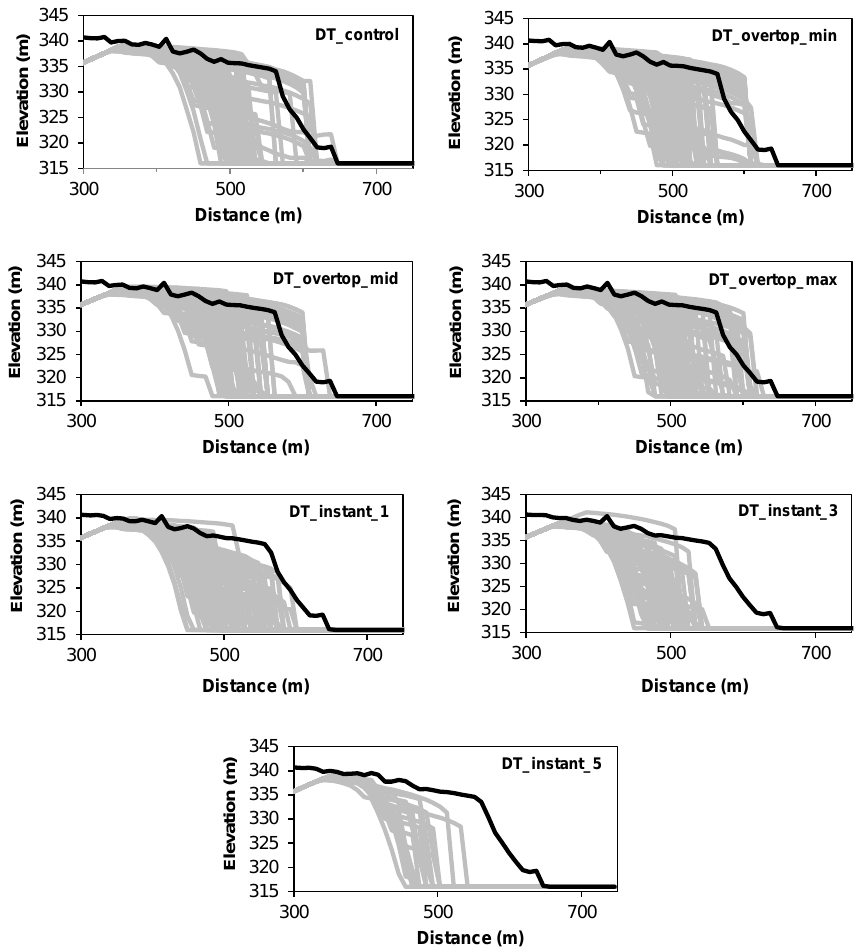
Figure 8. Final centreline breach elevation profiles for the Dig Tsho simulations. Black: observed profile; grey: modelled (behavioural)